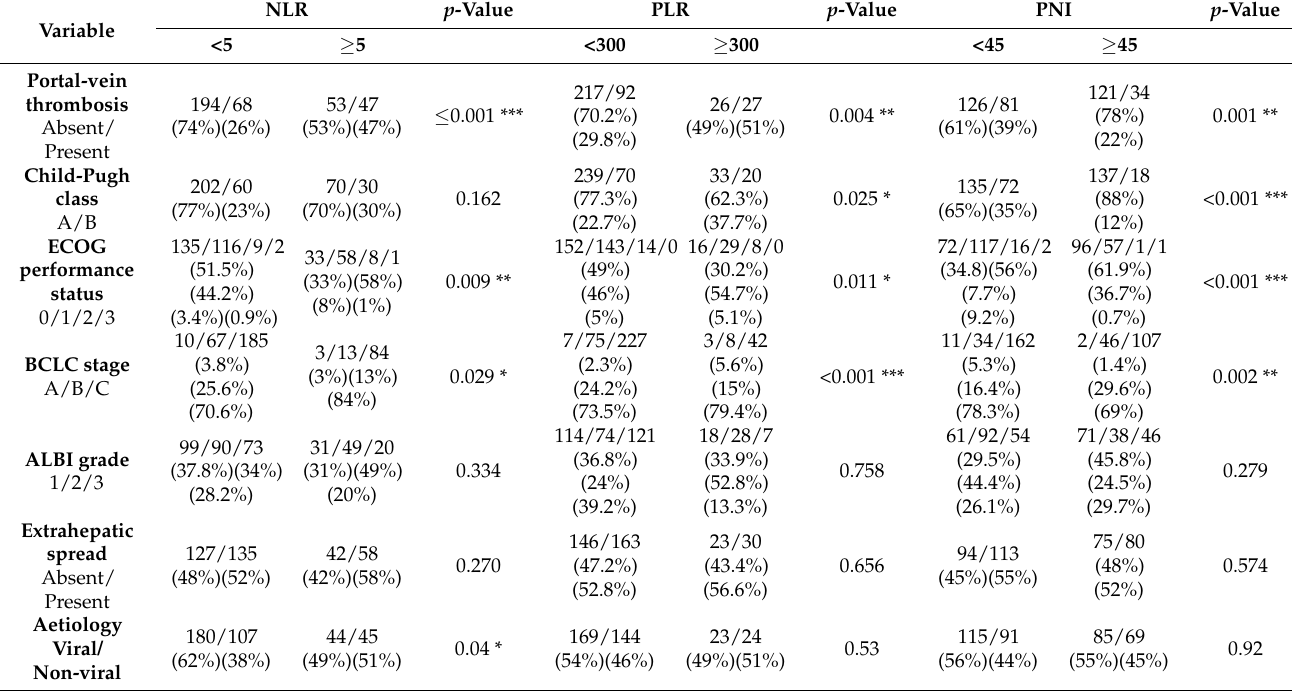
Table 2. Relationship between inflammatory status and baseline clinicopathological